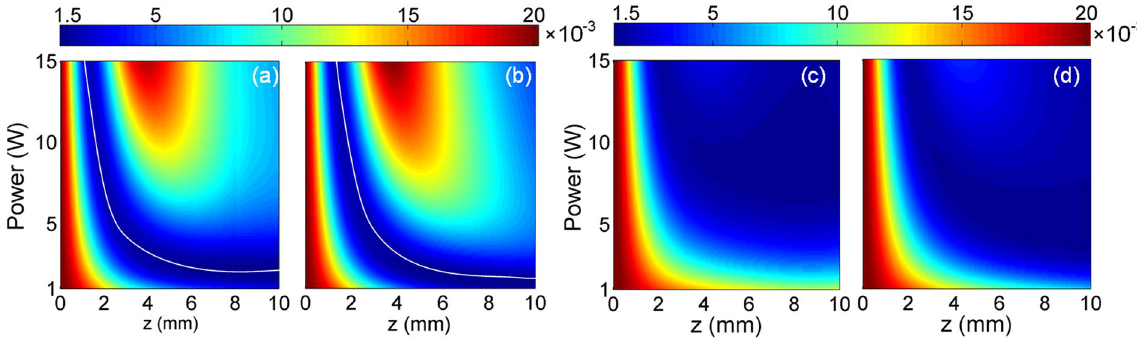
Figure 11. The mismatch δ 2 for ( a ) Full NIW at 1550 nm, ( b ) Full DDW at 1550 nm, ( c ) Full NIW at 2150 nm and ( d ) Full DDW at 2150 nm. The curves in white in ( a ) and ( b ) represent the minimum δ 2 at each power P